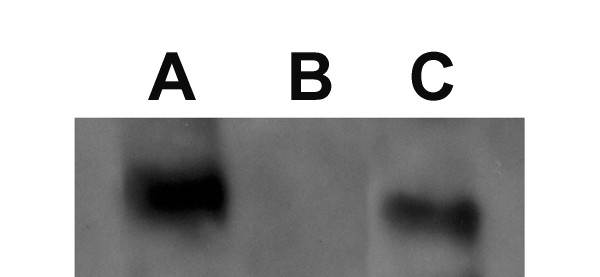
Nonreducing sodium dodecyl sulfate-PAGE gel of CYE of W. dermatitidis developed with L-DOPA. Synthesis of a black pigment consistent with melanin occurs in situ on the gel. Lane A, commercial laccase; lane B, 200 μg of W. dermatitidis strain wdpks1Δ-1 CYE of treated with KCN; lane C, 200 μg of W. dermatitidis strain wdpks1Δ-1 CYE. Similar results were seen with CYE from W. dermatitidis strains 8656 and wdpks1Δ-1.